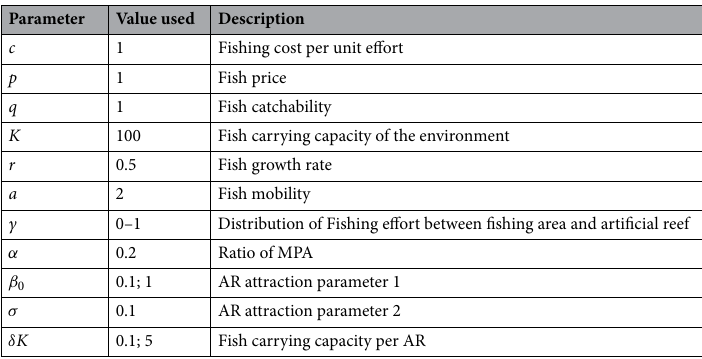
Distance to artificial reef Village (km) Main Fishing gear